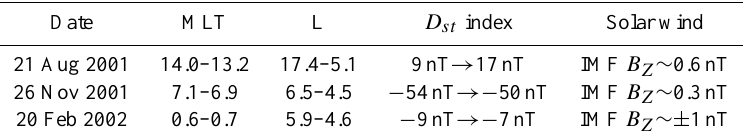
Table 1. summarises the observations of characteristics from the three